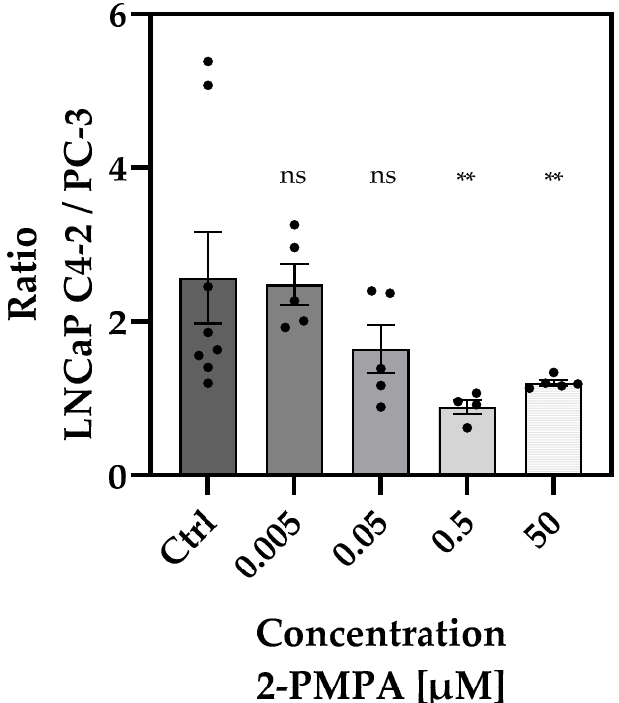
Figure 3. Overview of the ratios of [ 18 F]siPSMA-14 uptake in PSMA+ vs. PSMA − tumors treated with various 2-PMPA concentrations. For untreated control (Ctrl), a ratio of 2.6 ± 0.6 was determined. No significant difference to the Ctrl was observed for the lowest inhibitor concentration of 0.005 µ M and also for 0.05 µ M. A significant difference was observed for an inhibitor concentration of 0.5 µ M, indicating an equal tracer uptake in PSMA+ and PSMA − . A similar ratio was determined for the highest inhibitor concentration of 50 µ M 2-PMPA. Distinct values are summarized in Table 1. Each circle represents a single experiment. Concentration ratios between the control and the various con- centrations were assumed to be significantly different for p < 0.005 in the Mann-Whitney test. ns = not significant; ** p < 0.005.